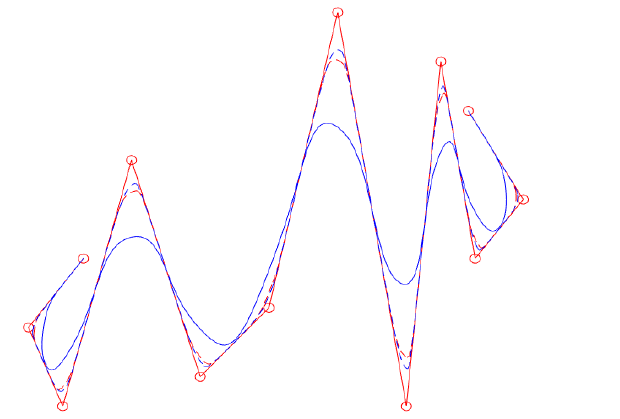
Figure 10. Comparisons among the new generalized quasi cubic trigonometric B-spline curves (blue dashed lines with α i ( t ) and β i ( t ) given in Equation (13), red dashed lines with α i ( t ) and β i ( t ) given in Equation (14)), trigonometric B-spline basis functions defined in [18] (blue solid lines) where λ i = µ i =